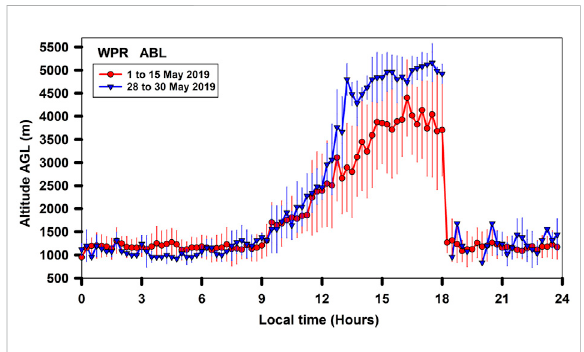
FIGURE 6 Estimated Atmospheric boundary layer height variation during dryline event from 28 to 30 May 2019 (blue line and triangles) and during 1 – 15 May 2019 (red line and triangles) based upon 15-min mean SNR pro fi les. Vertical bars indicate the standard deviations during the averaging